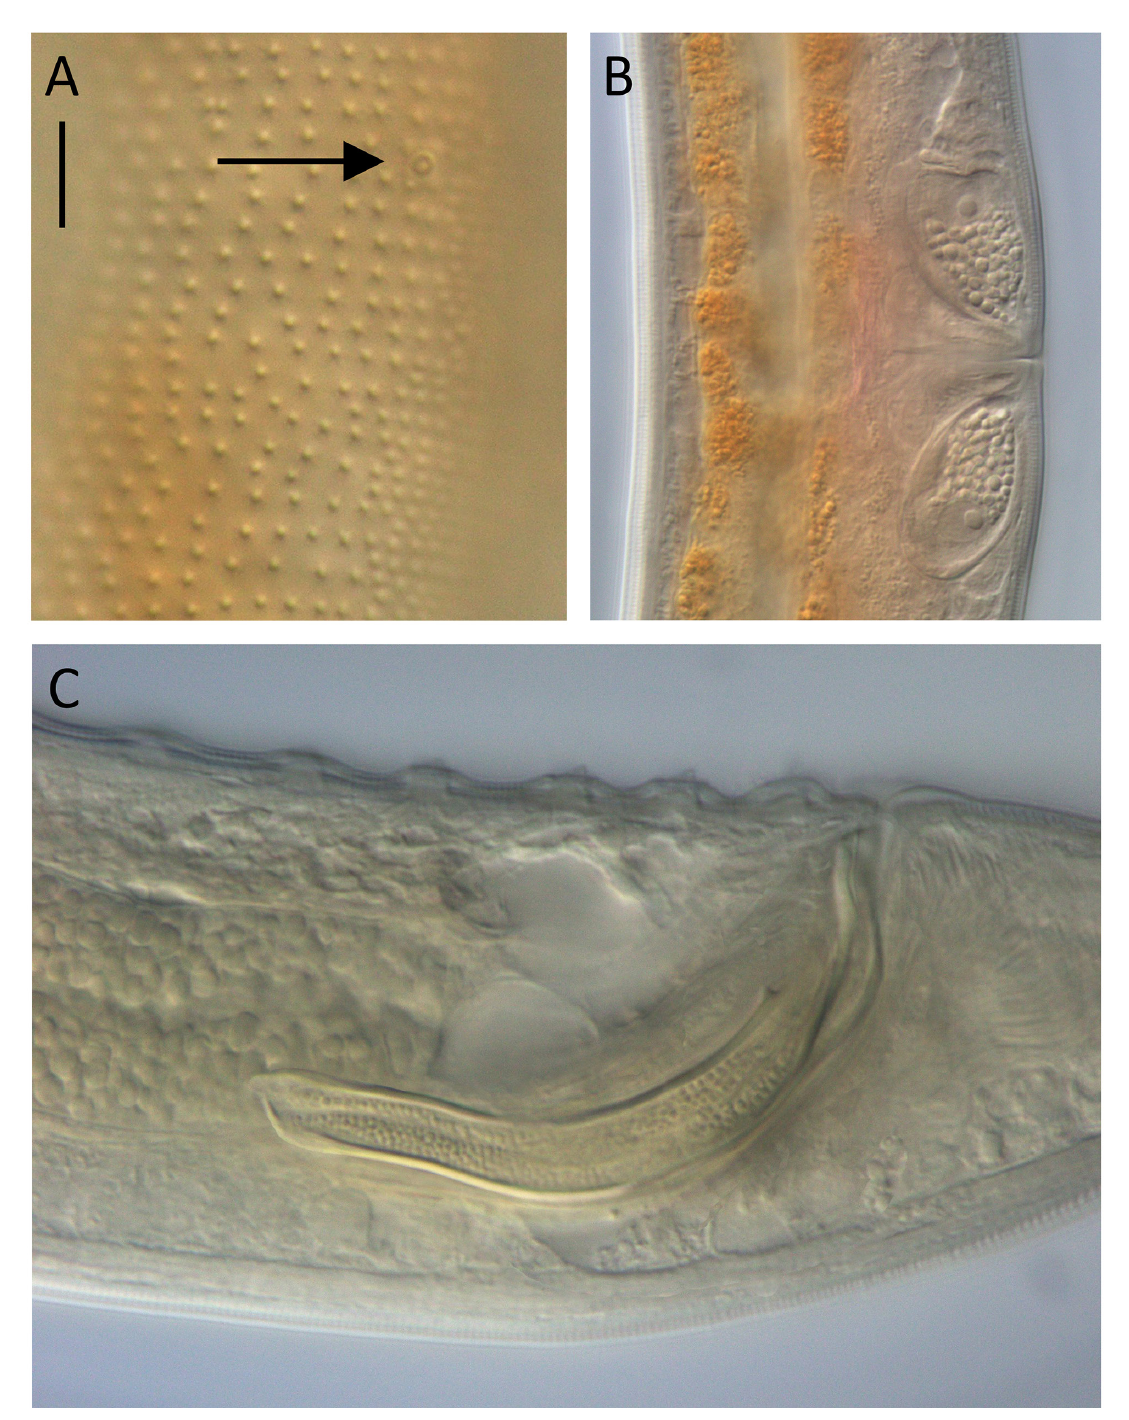
Fig. 3. Halichoanolaimus ovalis Ditlevsen, 1921. Light micrographs. A . Female cuticle showing lateral differentiation and pore complexes (arrow). B . Vulva, showing vaginal glands. C . Copulatory apparatus. Scale bar: A, C = 5 µm; B = 15